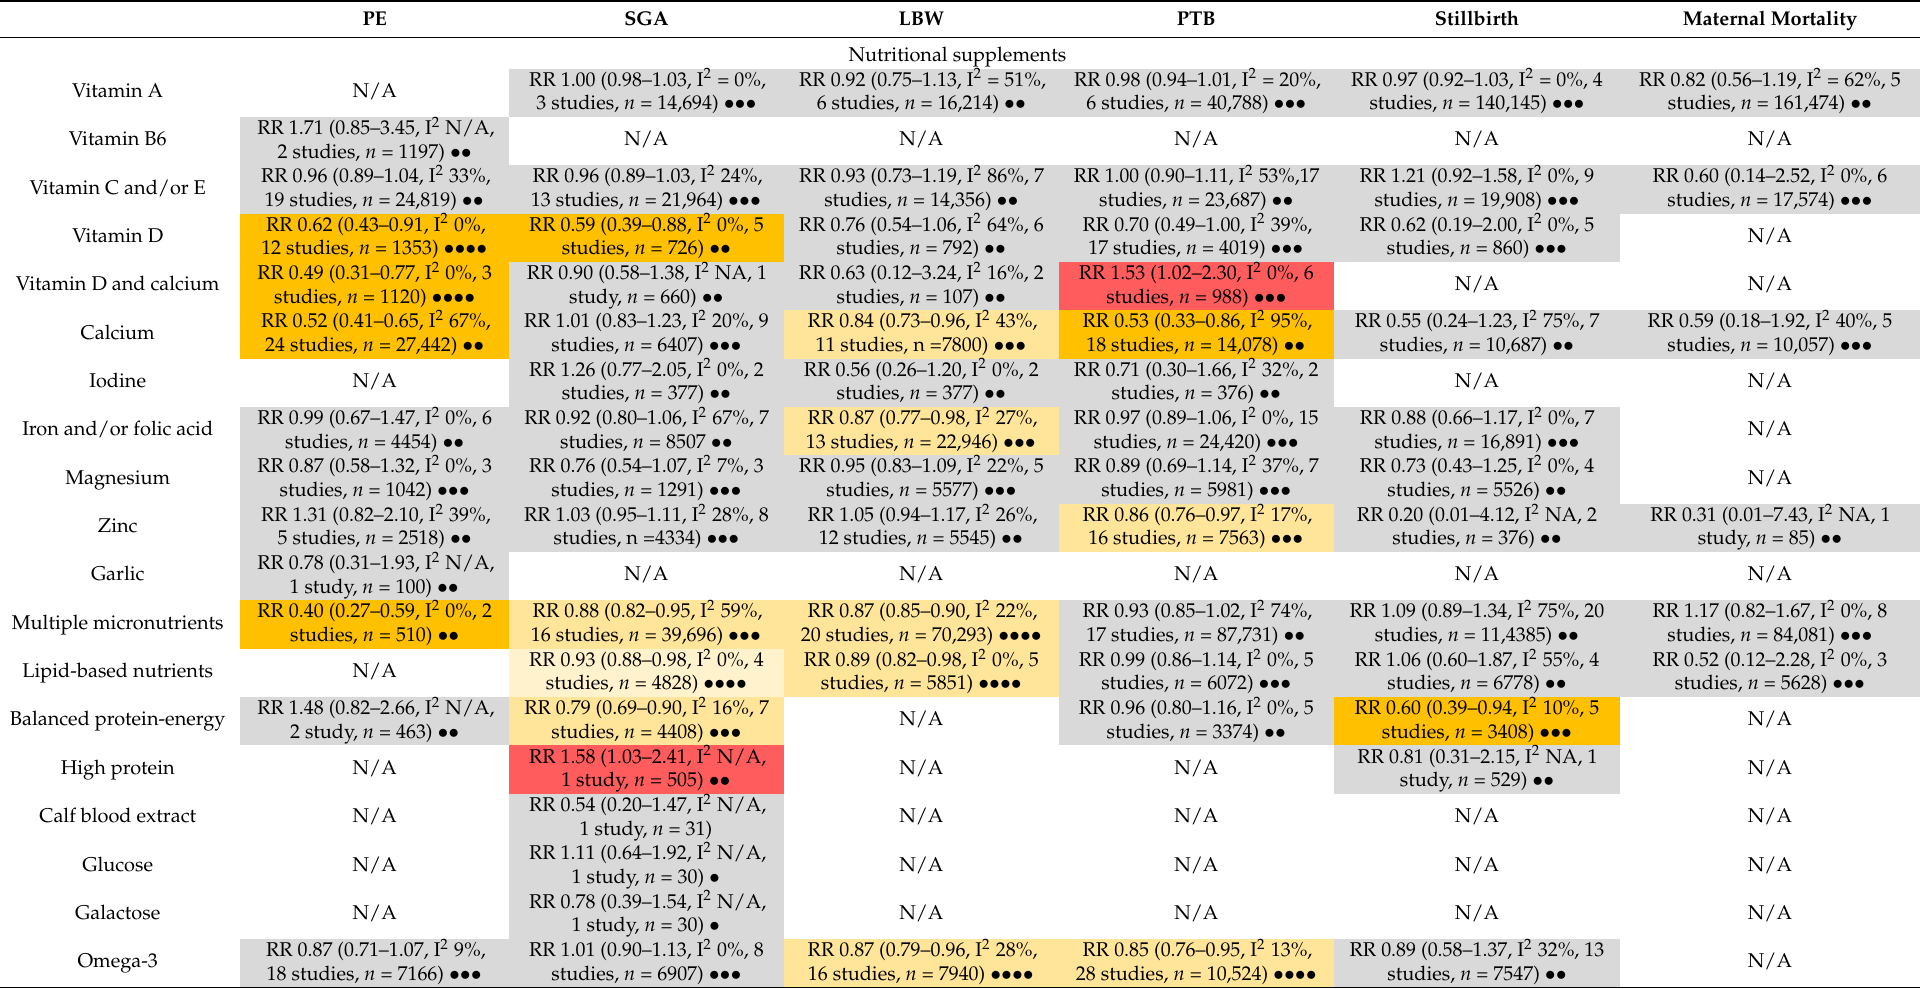
Table 1. Evidence map of direction of effect, strength of association and certainty of the